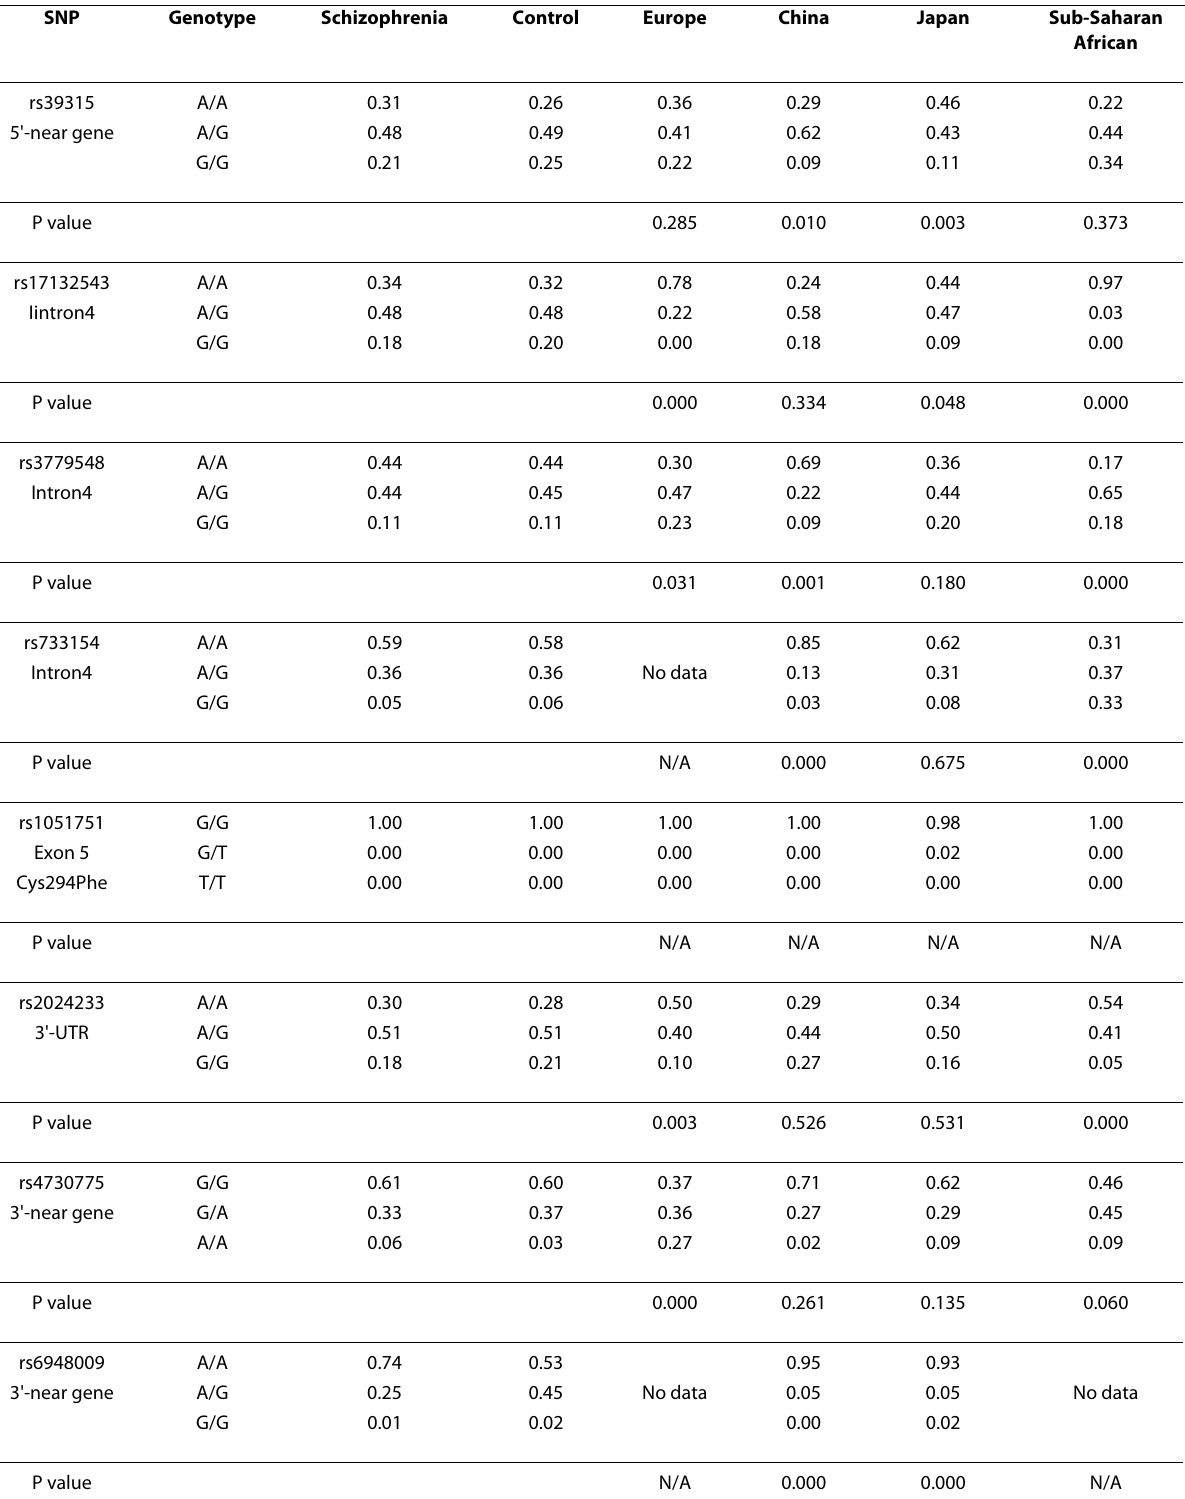
Table 6: WNT2 SNPs genotype frequencies in each population